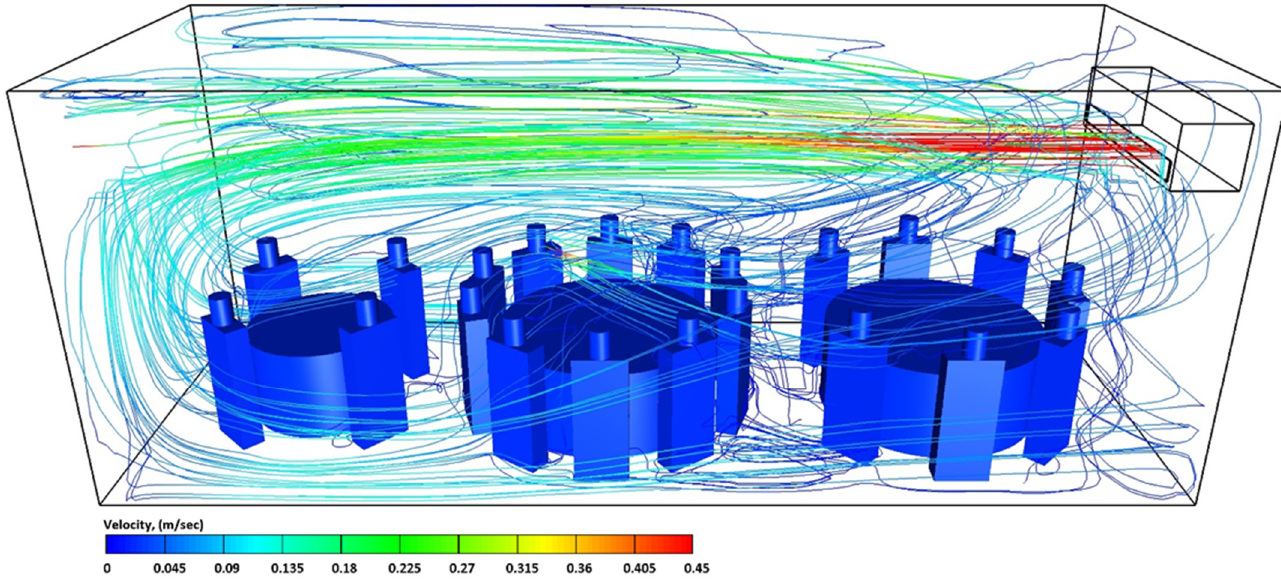
Figure 10. The airflow streamlines velocities in the computational domain at t = 4500 s for case-1.